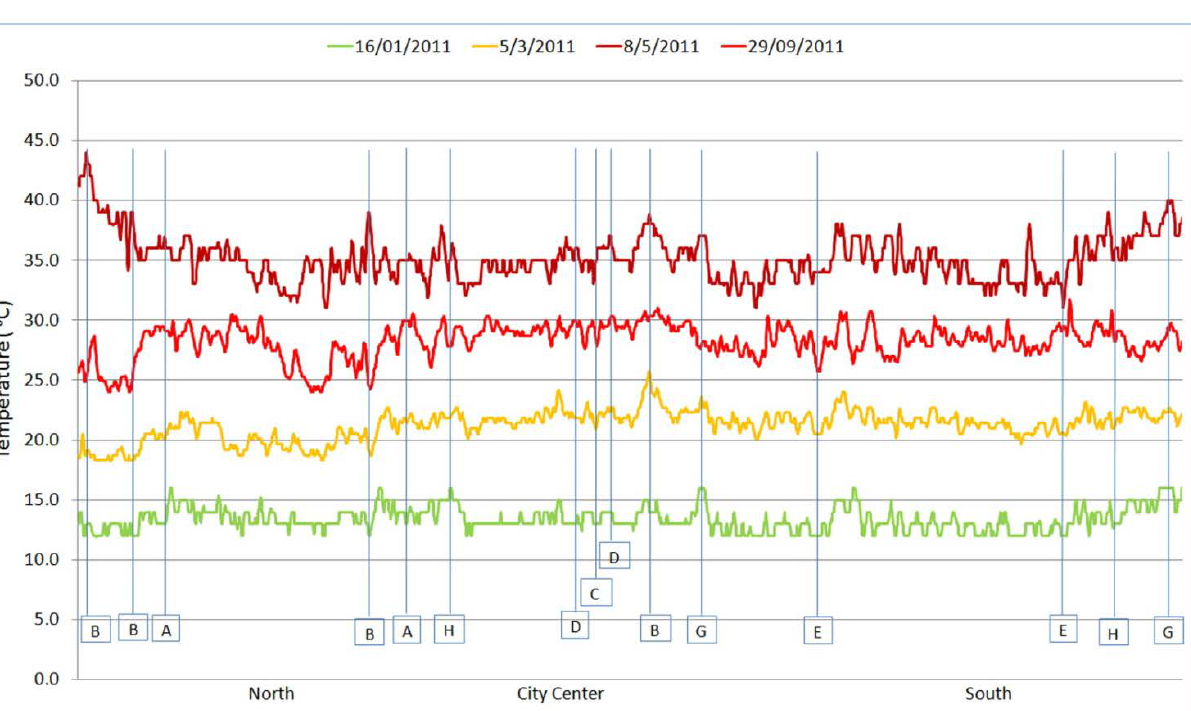
Figure 7. North-south profile of surface temperature and major land use/cover across Delhi. A—Rural built-up; B—Agriculture; C—Drain; D—Urban built-up; E—Vegetation; F—the Yamuna River; G—Rocky ridge; and